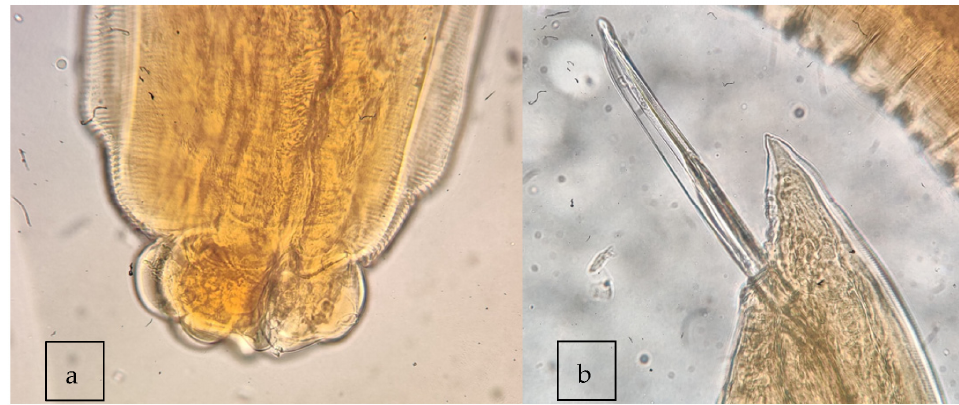
Figure 2. Photomicrographs of the Contracaecum adults found. ( a ) Mouth region of the adult form; ( b ) Tail region of the male adult form.